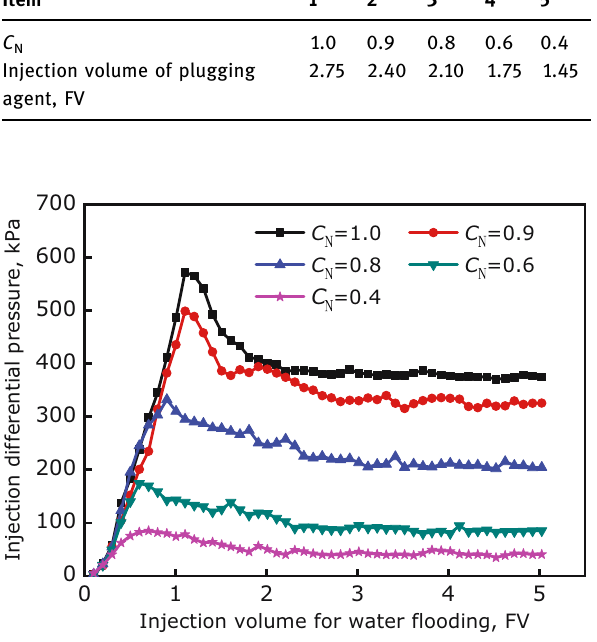
Figure 10: Reverse water fl ooding di ff erential pressures for the gel plugging agent at di ff erent leak o ff